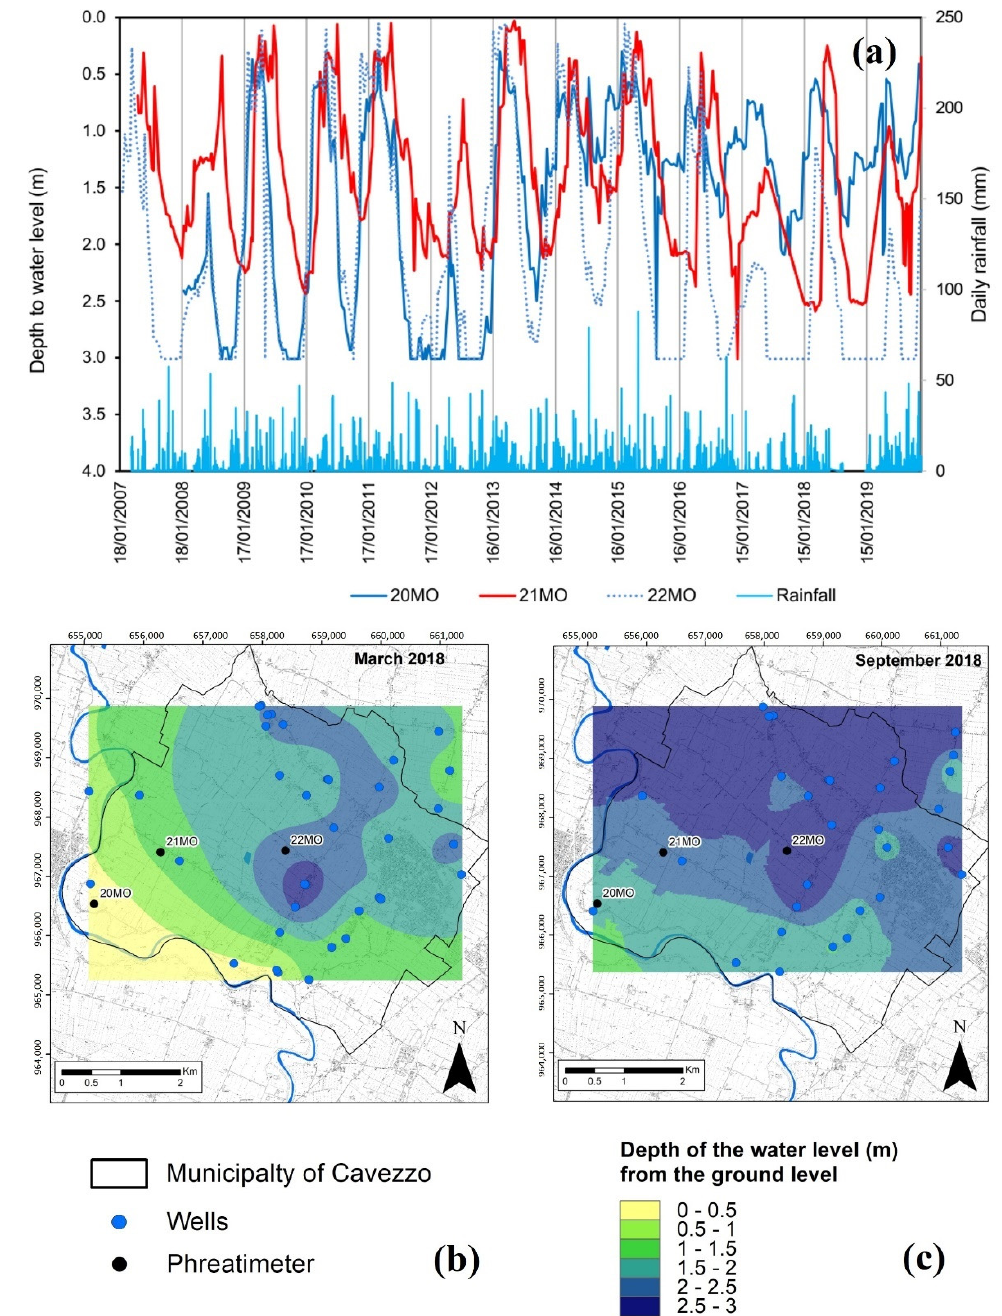
Figure 2. ( a ) Trend of the depth of the water level measured in the three phreatimeters and private wells monitored by ARPAE. The rainfall measured at Cortile Carpi (about 8 km from Cavezzo) is also shown. Depth of the water level was measured in March ( b ) and September ( c ) 2018.